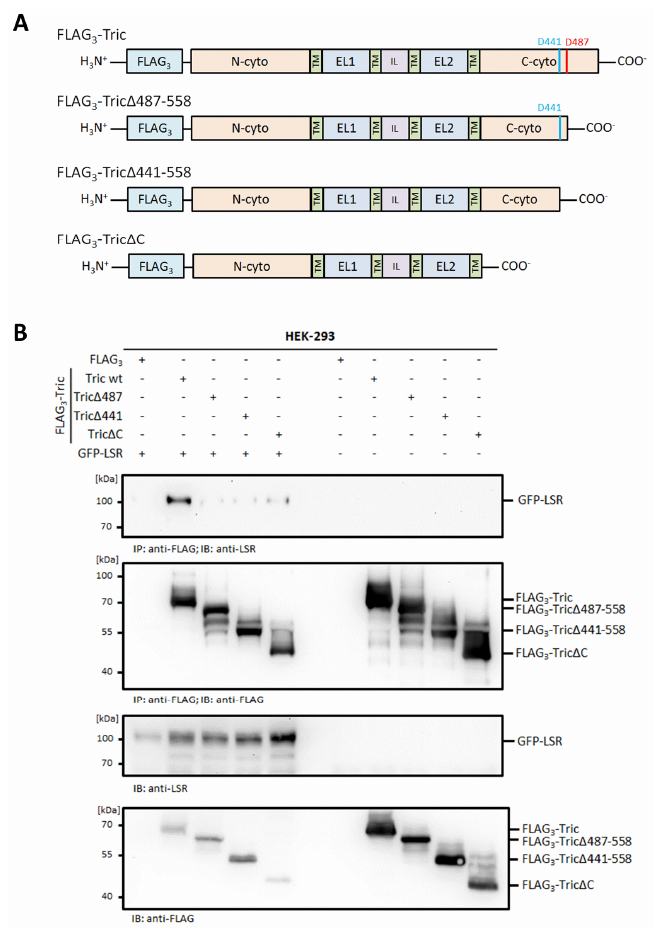
Figure 4. Deletion of the tricellulin C-terminus impairs binding to LSR/angulin-1. ( A ) Schematic representation of the FLAG 3 -tricellulin constructs used in the transient transfection experiments. TM, transmembrane domain; EL, extracellular loop; IL, intracellular loop. ( B ) HEK-293 cells were transiently transfected with FLAG 3 -tricellulin constructs missing the C-terminal tails corresponding to a cleavage by caspases together with GFP-LSR as indicated. Cells were lysed 48 h after transfection. Immunoprecipitaion (IP) was performed with monoclonal anti-FLAG antibody. Protein complexes from IP (upper two blots) and cell lysates (lower two blots) were analyzed by Western blotting with anti-LSR and anti-FLAG antibodies. The images are representatives of at least three independent